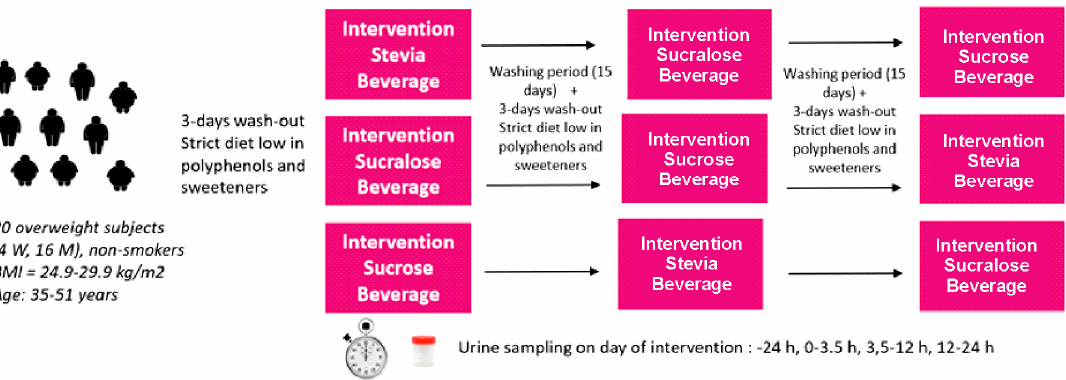
Figure 4. Cross-over study design.